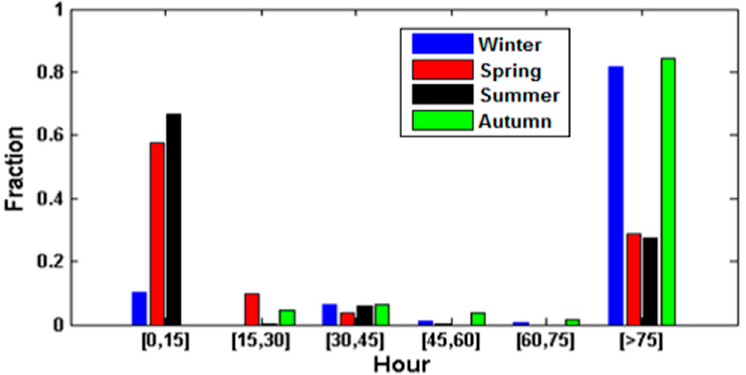
Figure 10. The fraction of time since the last BL/RL contact of >75-h back trajectories of air masses reaching the Puy de Dôme for the four seasons.